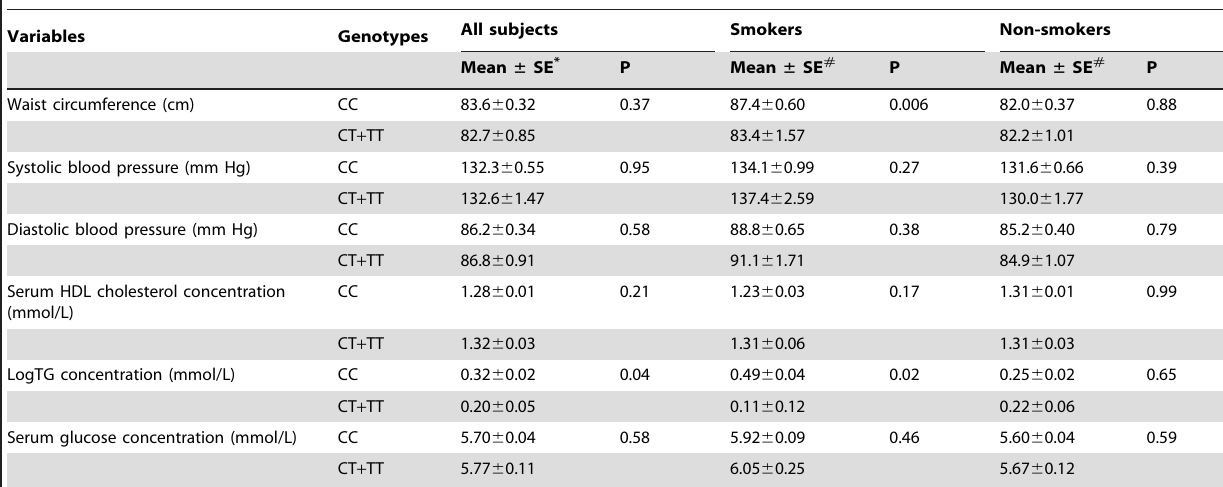
Table 2. Multiple regression analysis of C242T